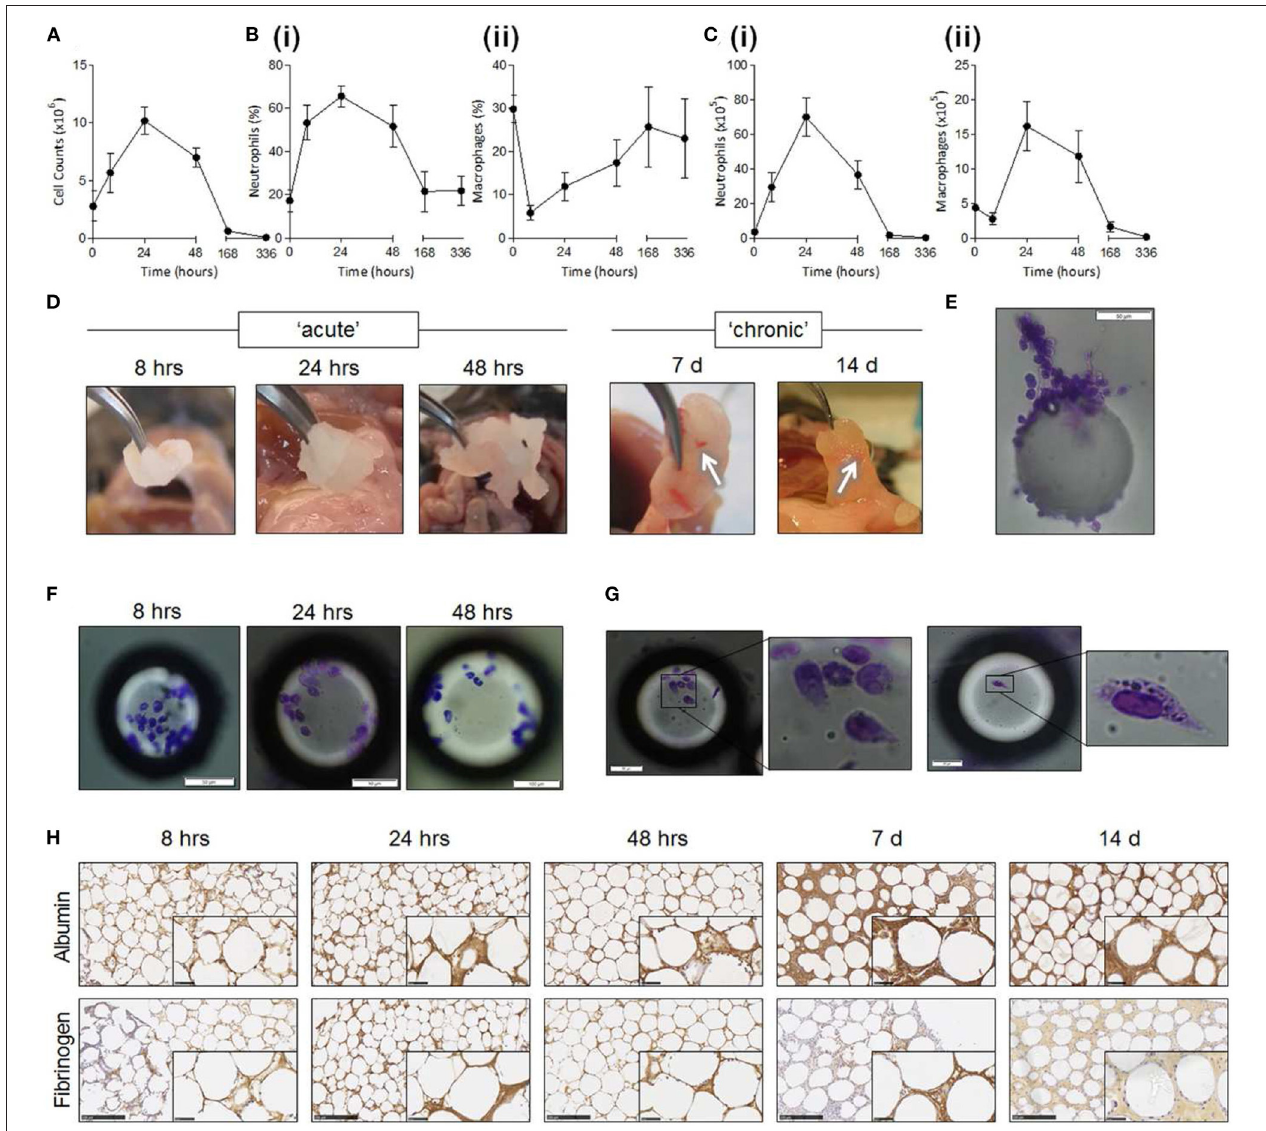
FIGURE 2 | Foreign body reaction against intraperitoneally-implanted PMMA beads (125–180 µ m). Reproduced under the terms of the Creative Commons Attribution License (Christo et al., 2016). Progression from acute to chronic FBR stages can be observed in counts of cells surrounding implants (A-C) and in the thickening of tissue capsule around them (H) . (A–C) Quantification of cell numbers in the peritoneum following bead implantation, of all cells (A) , neutrophils (B,C) (i), macrophages (B,C) (ii). (D) Explanted PMMA beads. Fibrotic encapsulation of beads visible at longer time points (white arrows). (E–G) Individual explanted beads stained